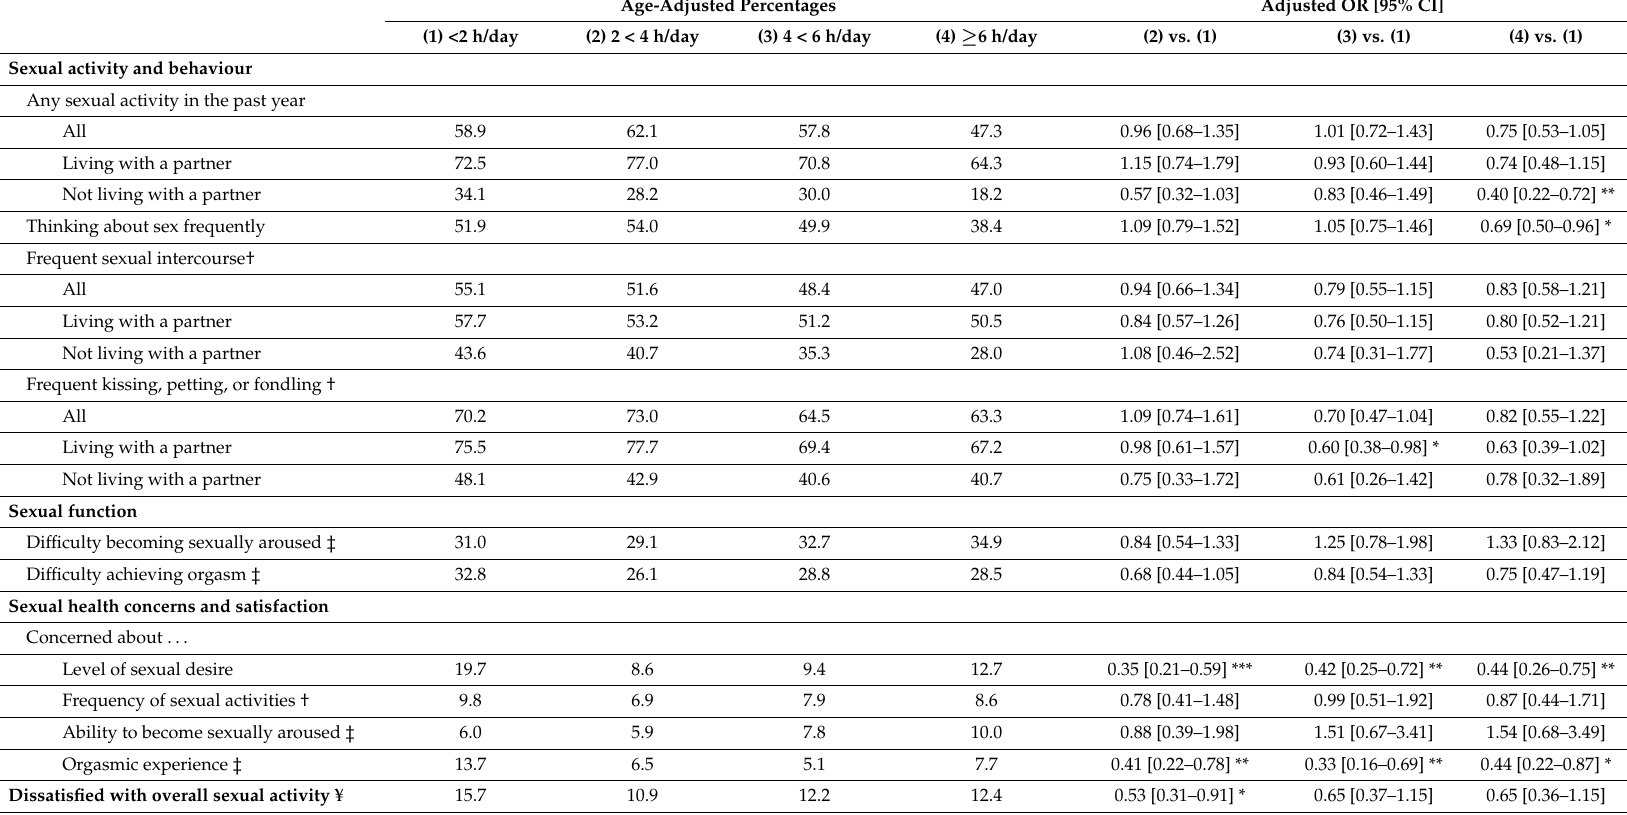
Table 5. Sexual activities, functioning and concerns in relation to hours of daily TV